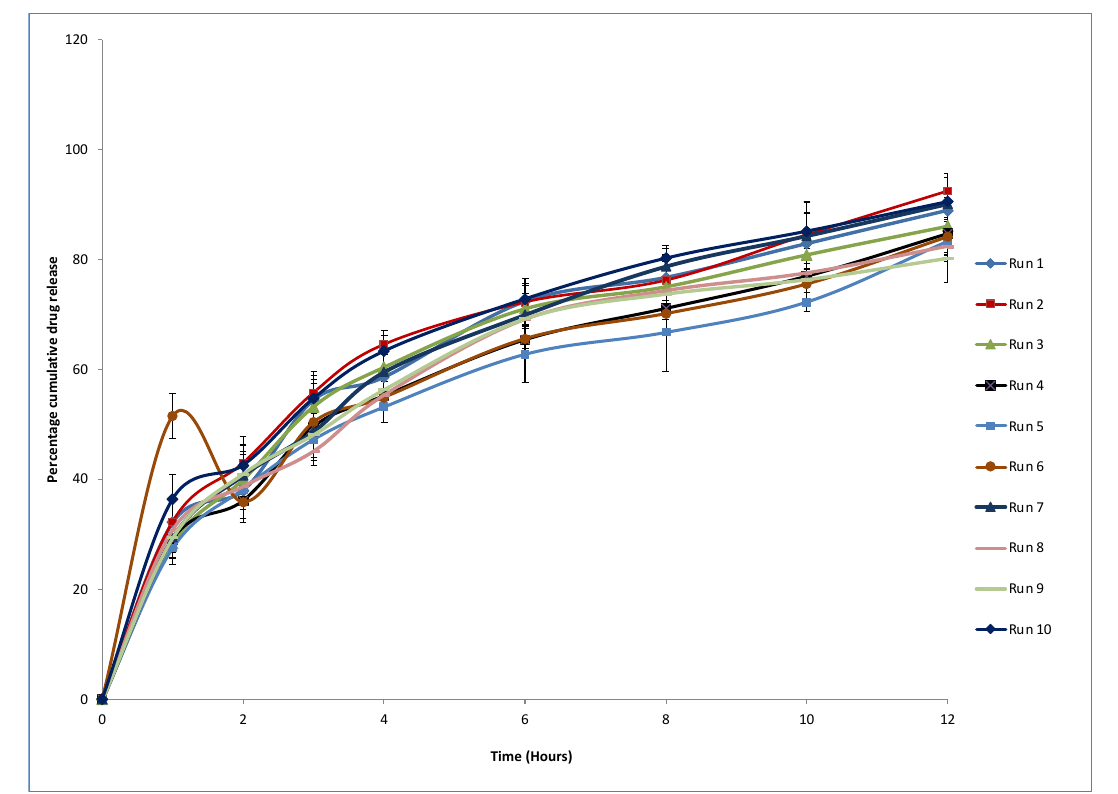
FIGURE 5 - In-vitro drug release for run 1-run10 suggested by CCD.